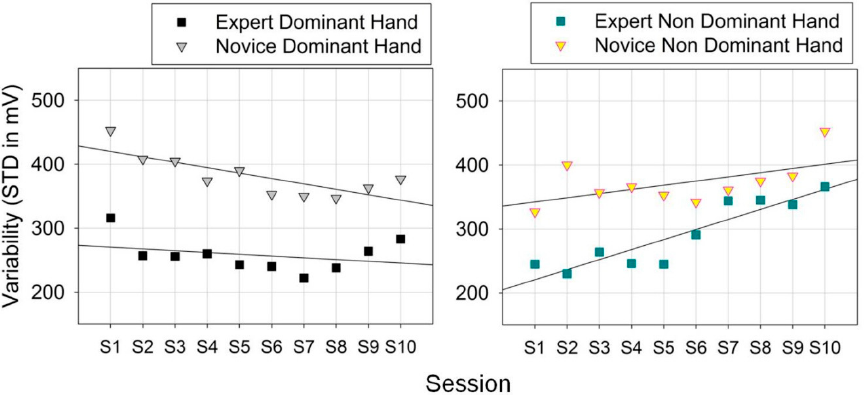
Figure 8. Variability (STandard Deviations of the means) in grip forces deployed by the novice and the expert by the dominant and the non-dominant hands in ten successive task sessions.